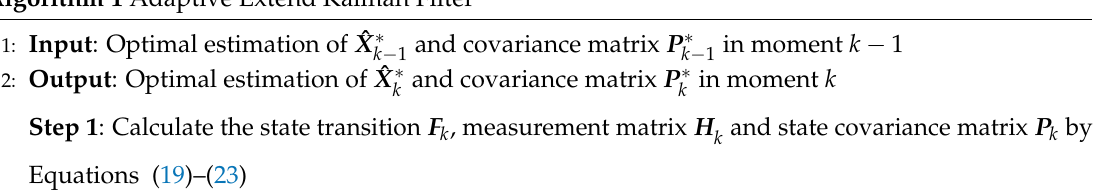
Algorithm 1 Adaptive Extend Kalman